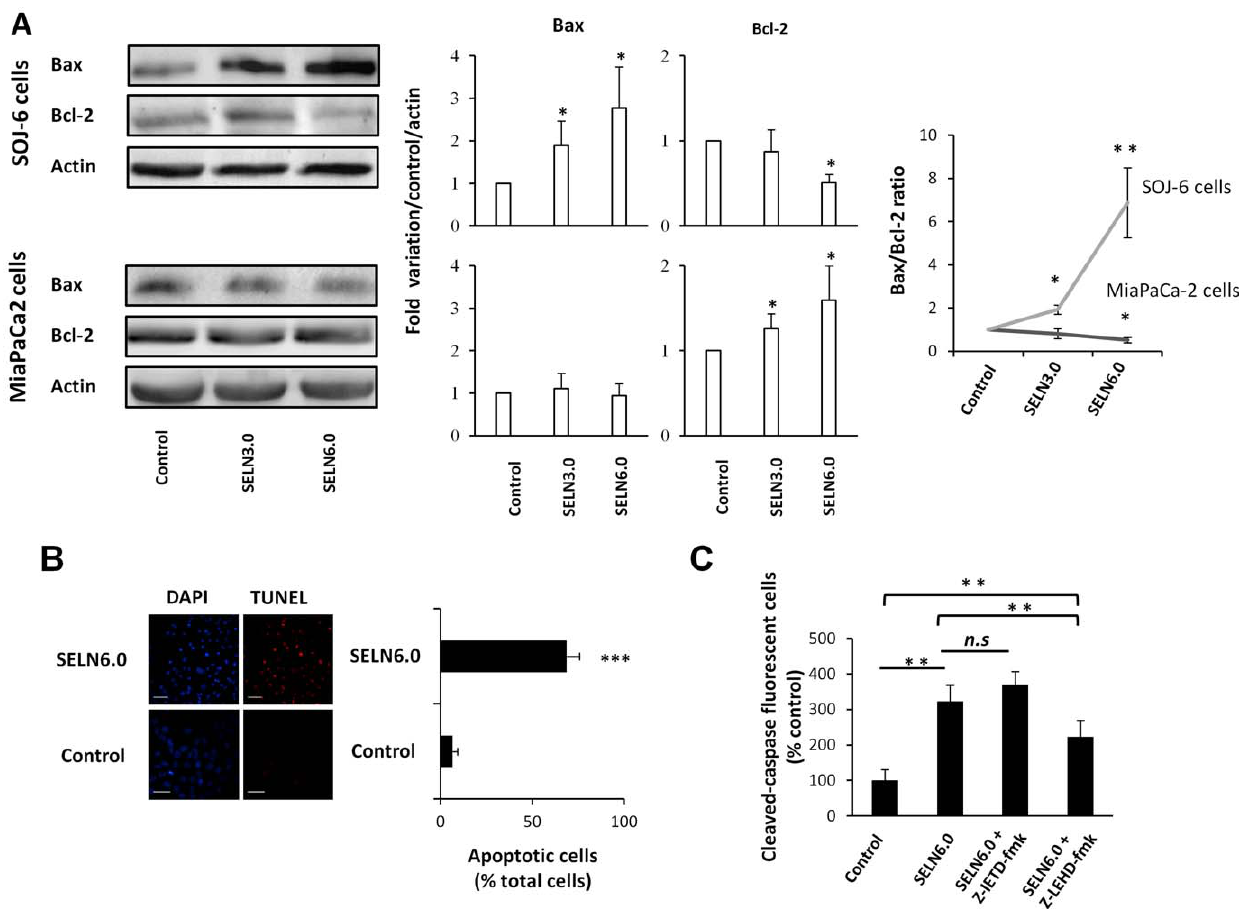
Figure 4. Effect of SELN on apoptosis. (A) SOJ-6 and MiaPaCa-2 cells were starved then treated for 24h with SELN (16 nmoles cholesterol/ml) and lysed. Cell lysate proteins were separated on SDS-PAGE (80 m g of proteins/lane) and electrotransferred onto nitrocellulose membrane. The levels of Bax, Bcl-2 and b -actin were determined by probing membranes with specific antibodies as indicated. Western blots are representative of three independent experiments. Lane 1; control performed in the absence of SELN, Lane 2; in the presence of SELN 3.0, Lane 3; in the presence of SELN 6.0. The right panels in figure 4A represents the quantification of western blots and the ratio Bax/Bcl-2. Data are means ( 6 SD) of three independent experiments using the NIH Image program (Mann-Whitney test). (B) Apoptosis was determined using the Terminal Transferase dUTP Nick End Labeling (TUNEL). SOJ-6 cells were starved then treated with SELN6.0 (16 nmoles cholesterol/ml) for 24h then fragmented DNA was stained according to the protocol given with the ApopTag H Red In Situ Apoptosis Detection Kit (right pictures). Nuclei were counterstained with DAPI (left